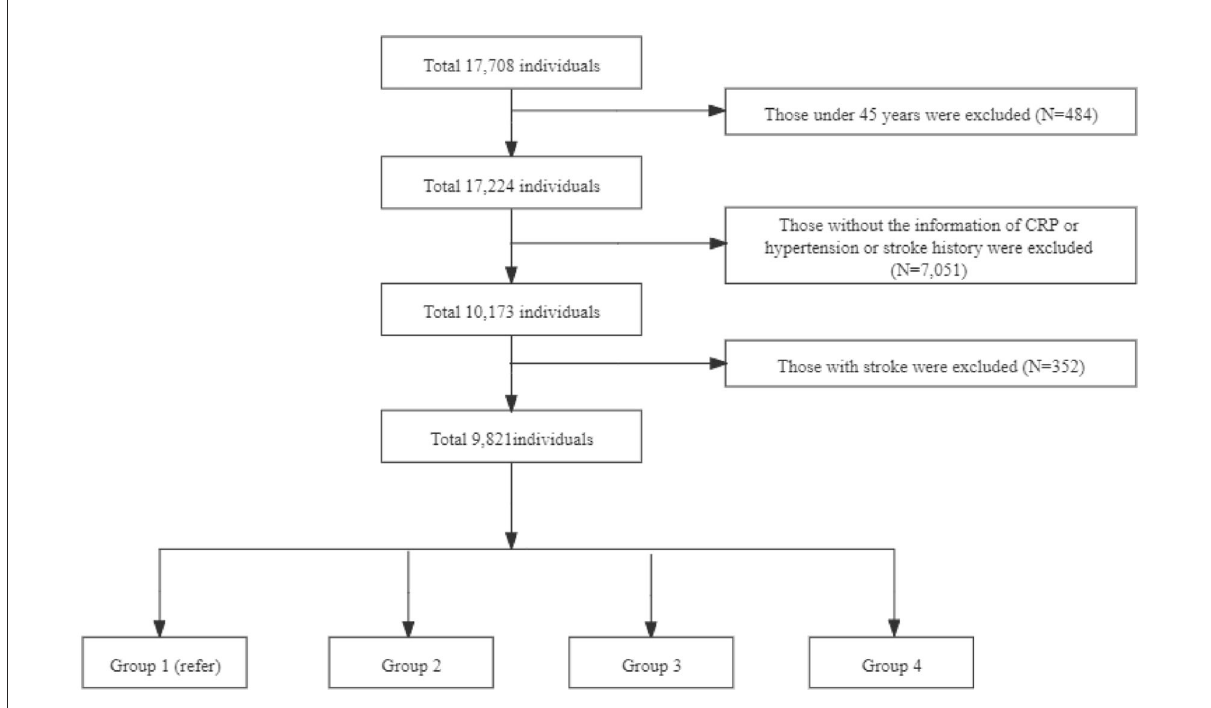
FIGURE1 Flowchart of participant selection in